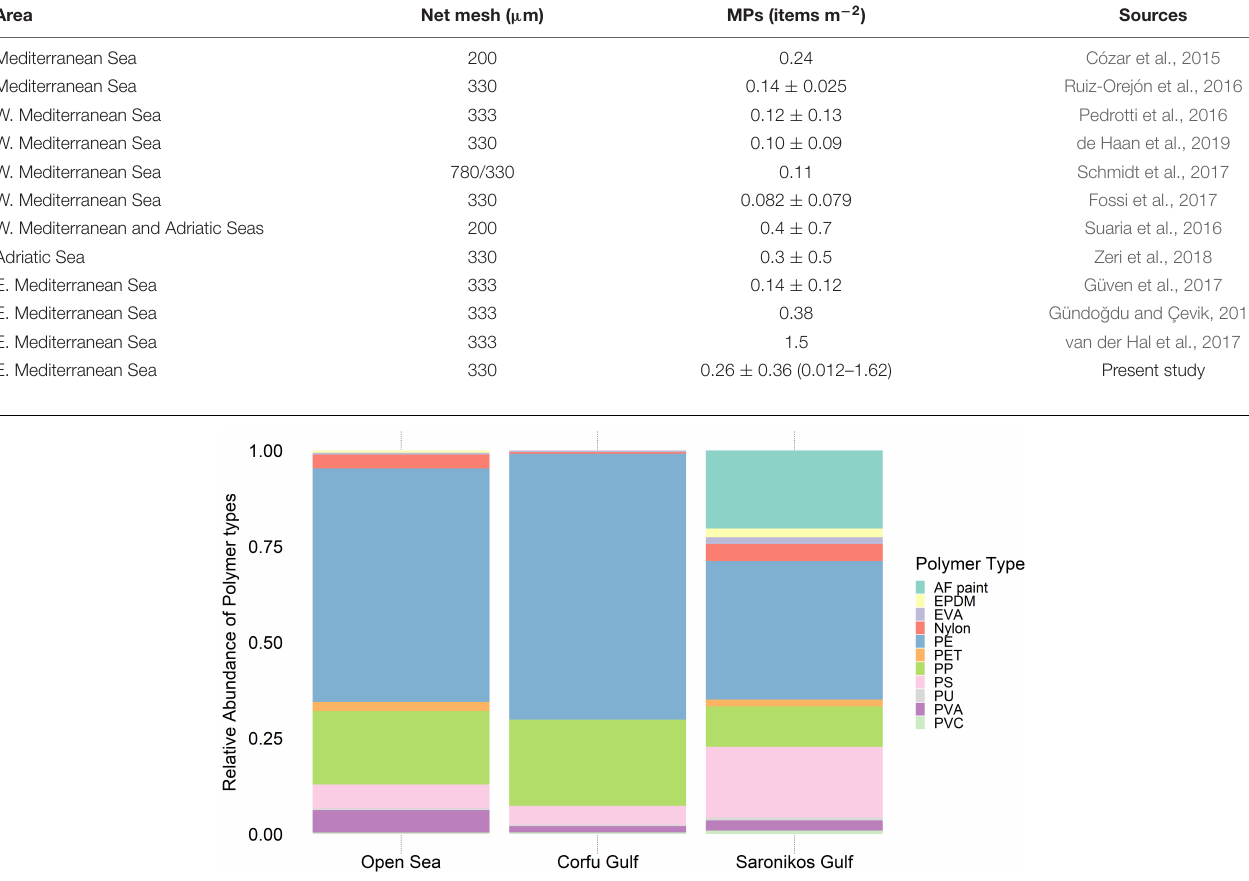
TABLE 3 | Sea surface MPs concentrations (items m − 2 ) reported for the Mediterranean Sea, using surface manta nets. Area